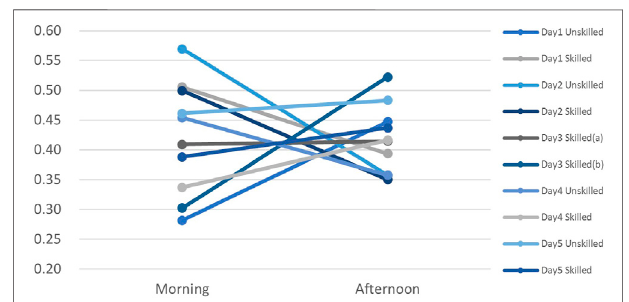
FIGURE 6 | The ratio of walking in morning/afternoon activities.